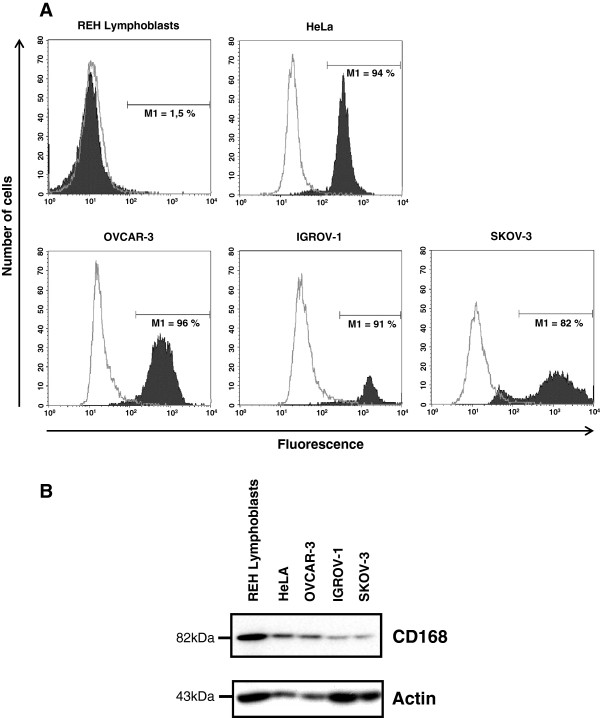
CD44 and CD168 expression in ovarian cancer cell lines. (A) The CD44 expression was measured by flow cytometry and analyzed with Cell Quest Pro software in ovarian cancer cell lines OVCAR-3, IGROV-1 and SKOV-3 as well as in REH lymphoblasts (negative control) and HeLa cells (positive controls). The auto fluorescence level was determined with an isotype control antibody (empty area). The CD44 expression was determined with an anti-CD44 antibody (full area) leading to the determination of the percentage of CD44 positive cells (M1). (B) The CD168 level was determined by western blot using a specific antibody in ovarian cancer cell lines OVCAR-3, IGROV-1 and SKOV-3 as well as in REH lymphoblasts and HeLa (positive controls). Immunocomplexes were visualized with a photon camera.